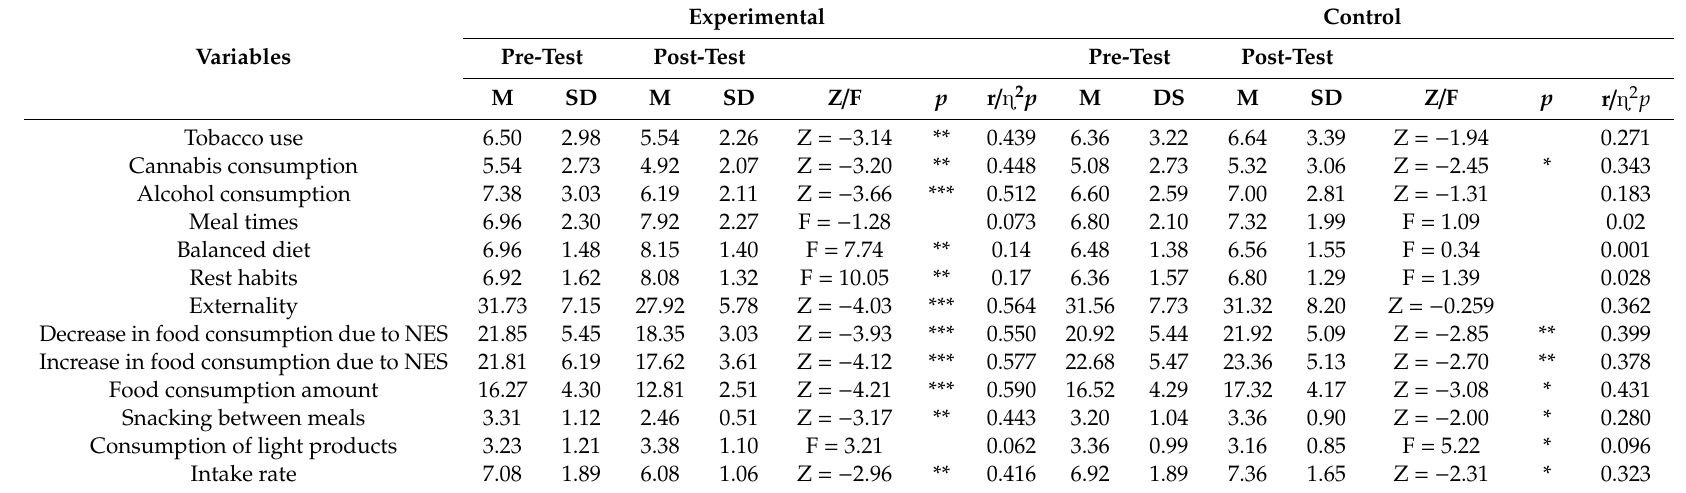
Table 2. Descriptive, ANOVA, and Wilcoxon test for related samples: Pre-test and post-test intra-group di ff erences in the study variables and Eta square.